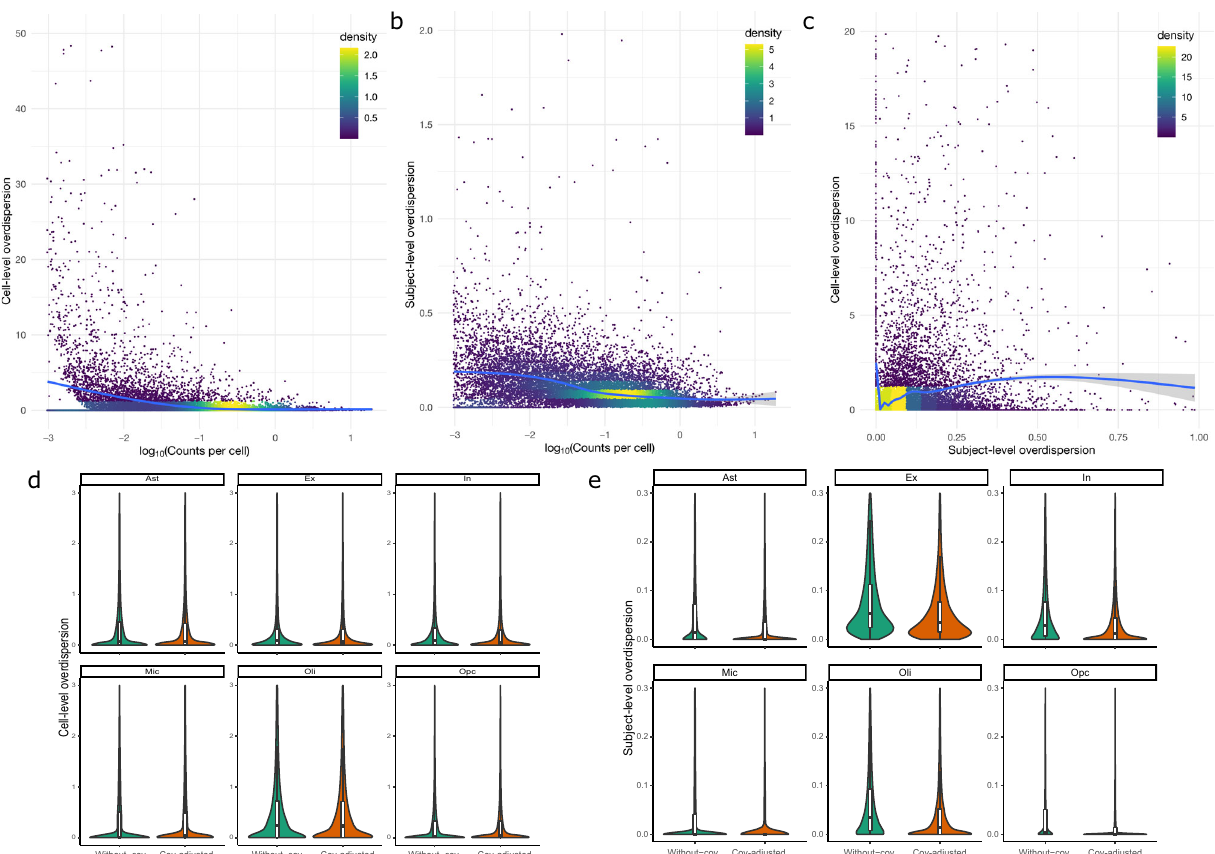
Fig. 4 Decomposed cell-level and subject-level overdispersions in major neural cells. a The cell-level overdispersion and b the subject-level overdispersion of 16,207 genes in the excitatory neurons estimated by NEBULA across different CPC values. No covariates other than the intercept were included in the model. The color indicates the two-dimensional kernel density computed using the kde2d R function with n = 100. c The cell-level overdispersion of 16,207 genes in the excitatory neurons estimated by NEBULA versus their subject-level overdispersion. d The estimated cell-level overdispersion and e the estimated subject-level overdispersion in each of the six brain cell types before and after adjusting for age, sex, race, AD status, the total number of features of the cell, and the percentage of ribosomal genes. Only genes with CPC > 0.1% in the relevant cell type were included in the above results. The cells in this analysis are from the 48-subject snRNA-seq data set 5 in the frontal